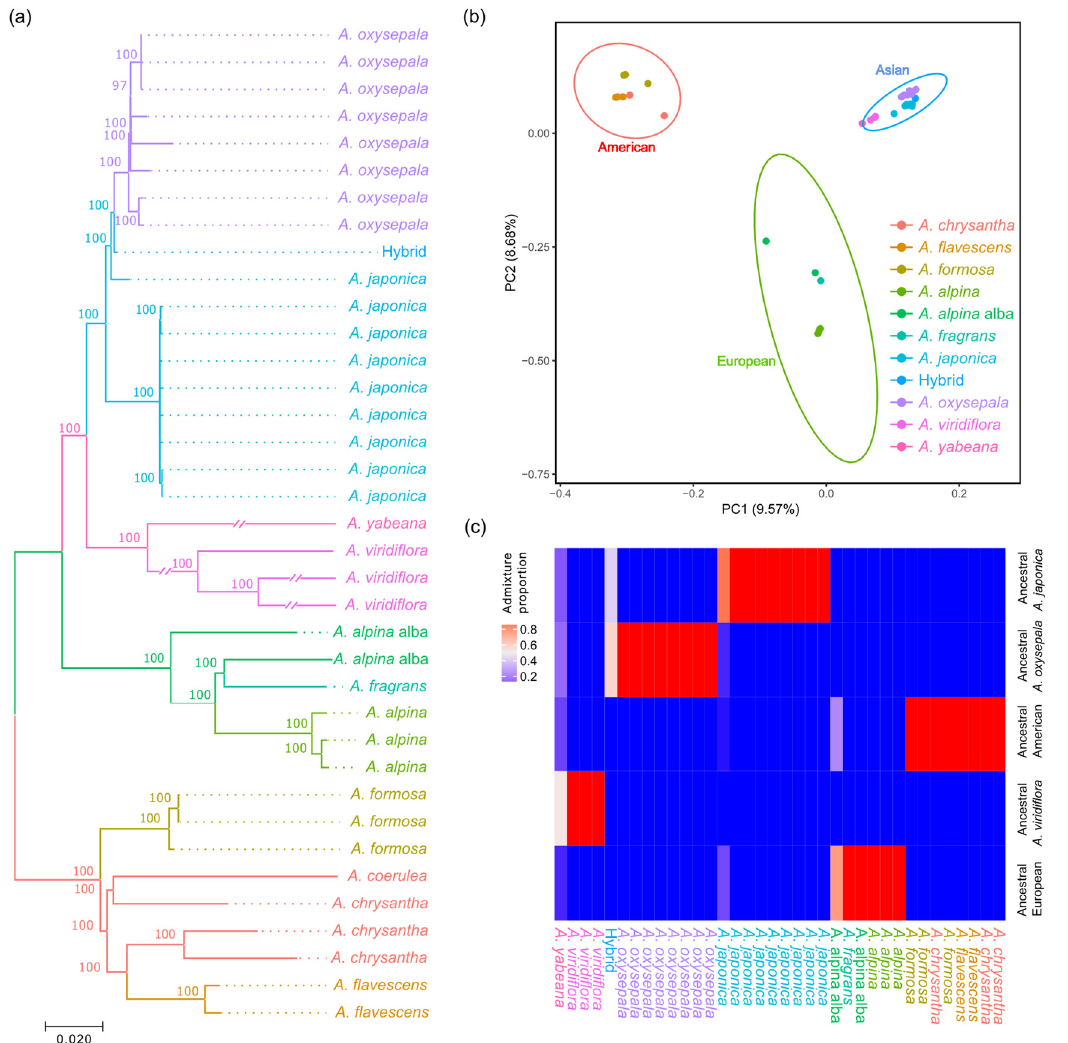
Figure 1. Phylogenetic relationship and population structure of the ten worldwide Aquilegia species. ( a ) Phylogenetic tree of the 36 accessions, constructed by a neighbor-joining algorithm based on